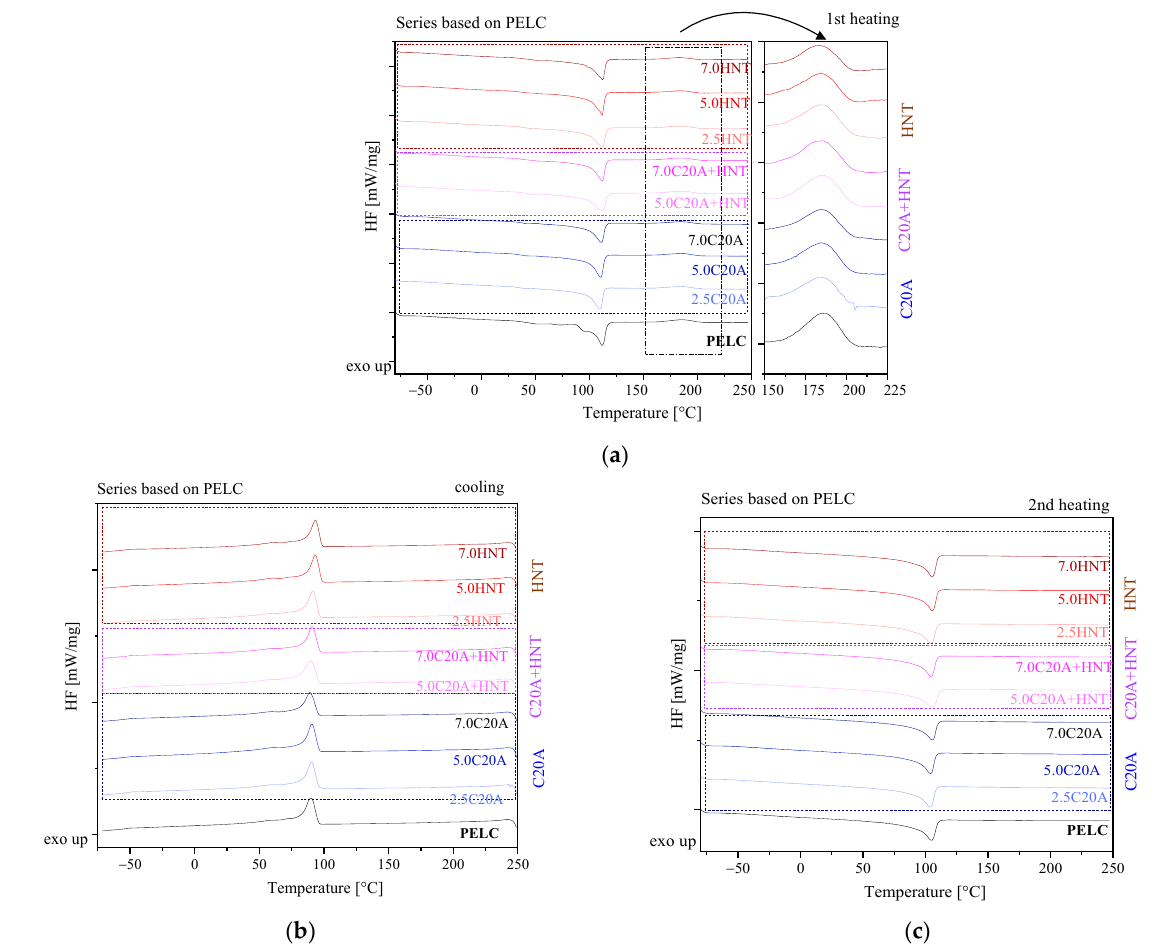
Figure 6. DSC thermograms recorded during first heating: ( a ) first heating; ( b ) cooling; ( c ) second heating for the series of nanocomposites based on PELC.